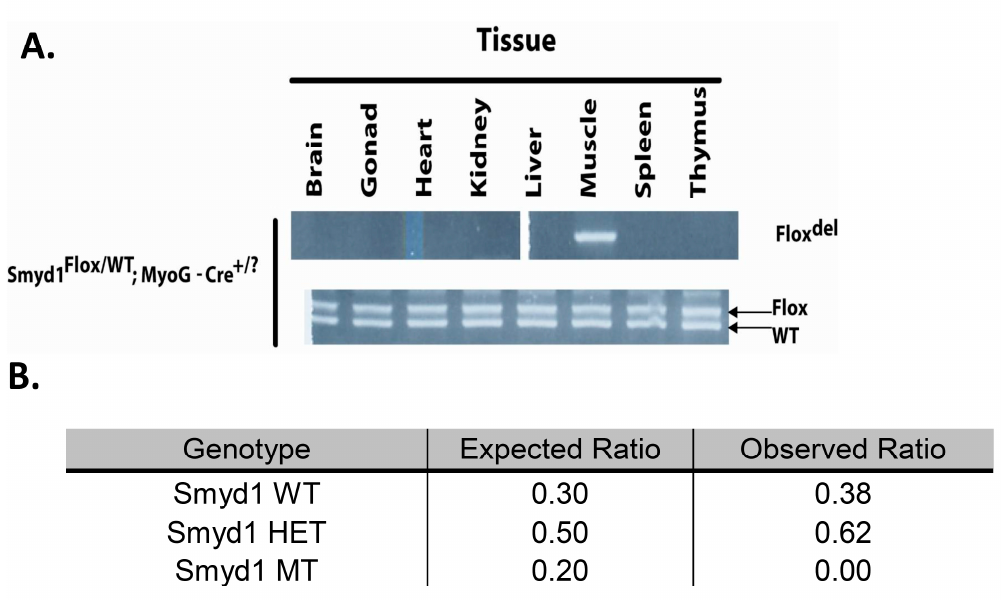
Figure 1. MyoG-Cre deletion of Smyd1 is muscle-specific lethal. ( A ) MyoG-Cre induces recombination of Smyd1 specifically in muscle. DNA was prepared from the tissues of a heterozygous Smyd1 mice. Recombination was assayed in the upper panel and the positive control Flox/WT assay was assayed in the lower panel. ( B ) Skeletal muscle-specific Myog-Cre/Smyd1 conditional knockout (CKO) is lethal prior to weaning. Various Smyd1 Flox/KO/WT /MyoG-Cre crosses obtained an N of 350. We expect that 20% of pups to be homozygous for Smyd1 -deficient alleles, 50% of pups should be heterozygous, and 30% should be wild type ( WT ). Litters were genotyped at weaning and the observed numbers were recorded. There was no significant reduction in litter size between birth and